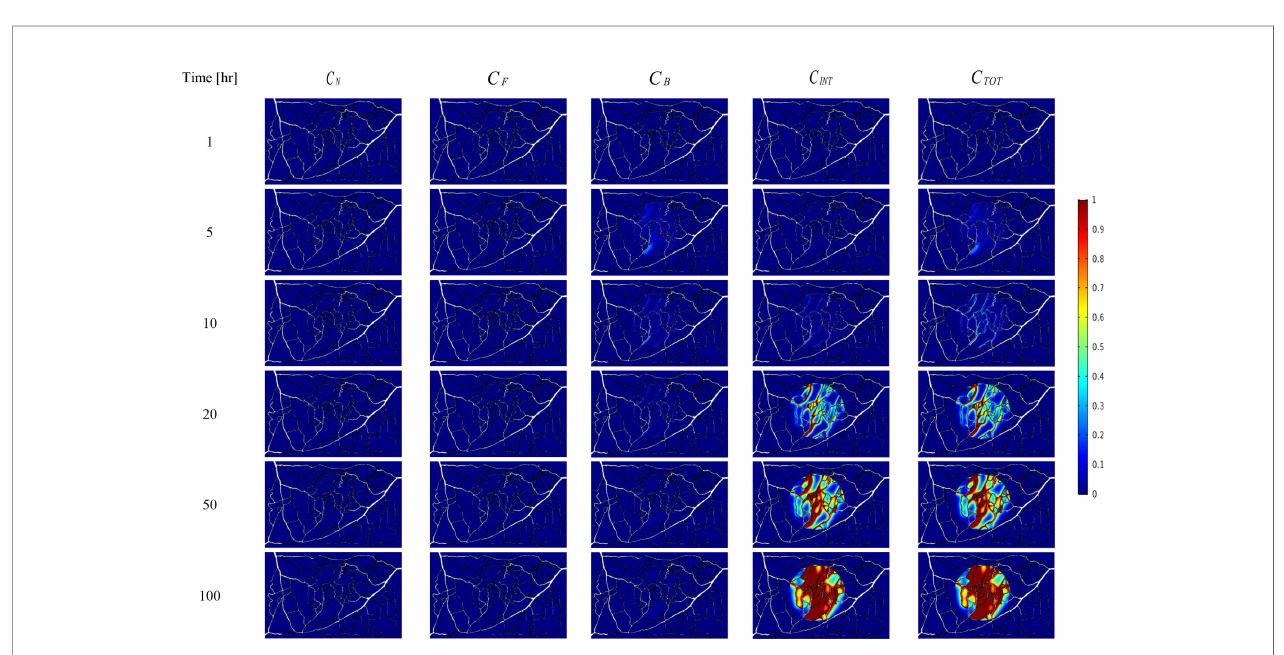
FIGURE 5 | Spatiotemporal distributions of concentrations of chemotherapy drug in tumor and its surrounding normal tissue with increasing time. These non-dimensional concentrations e C INT were calculated at a given time by dividing that concentration at any point of geometry by the maximum concentration in the whole